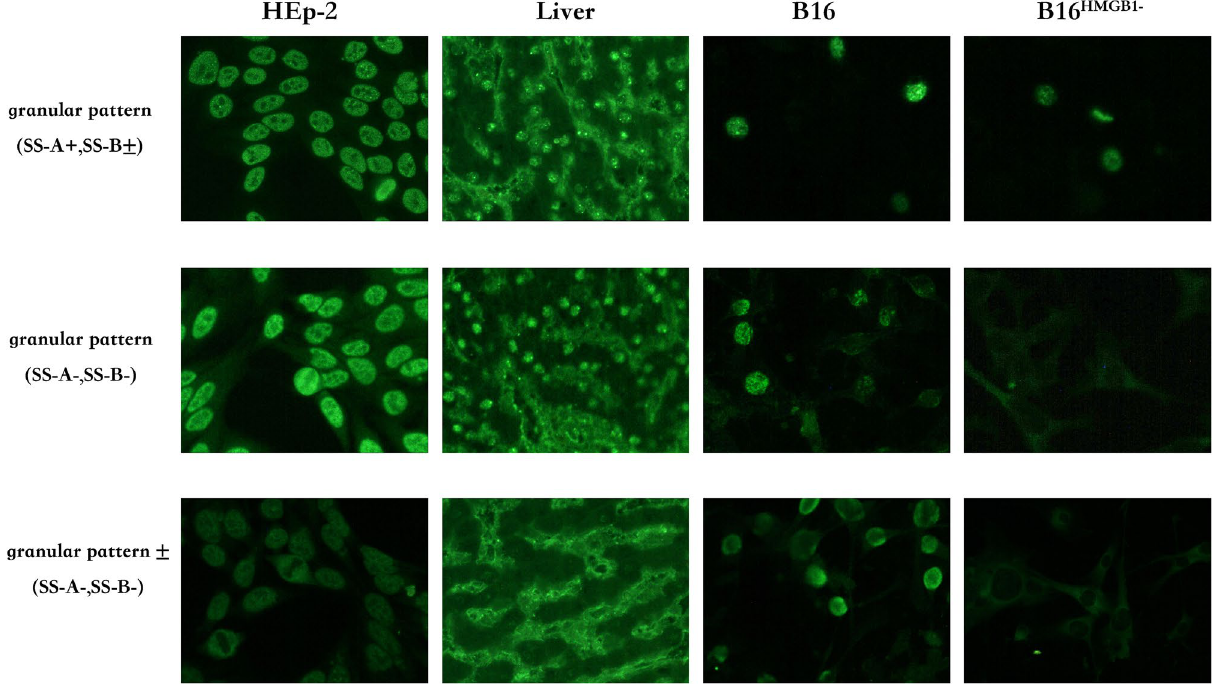
ANA (+), (SS-A−, SS-B−), there is nuclear fine speckled (AC-4) pattern in B16 cells, while no fluorescence in B16 HMGB1− cells. Down: ANA (±), (SS-A−, SS-B−), there is nuclear fine speckled (AC-4) pattern in B16 cells, while no fluorescence in B16 HMGB1−